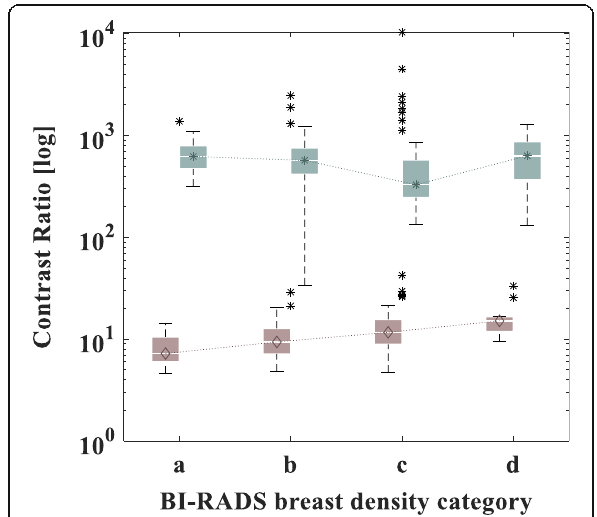
Fig. 3 Plot comparing the contrast ratio, in logarithmic scale, of the unprocessed recent image and the image created by temporal subtraction, for the four categories of BI-RADS breast density. The contrast ratio increased indicating that temporal subtraction is successful for all breast densities